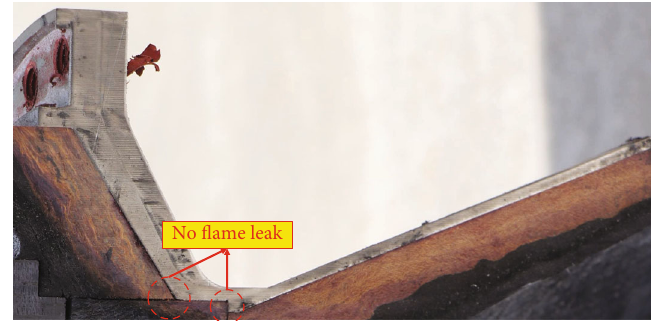
Figure 18: Overview of the metal case after fi ring